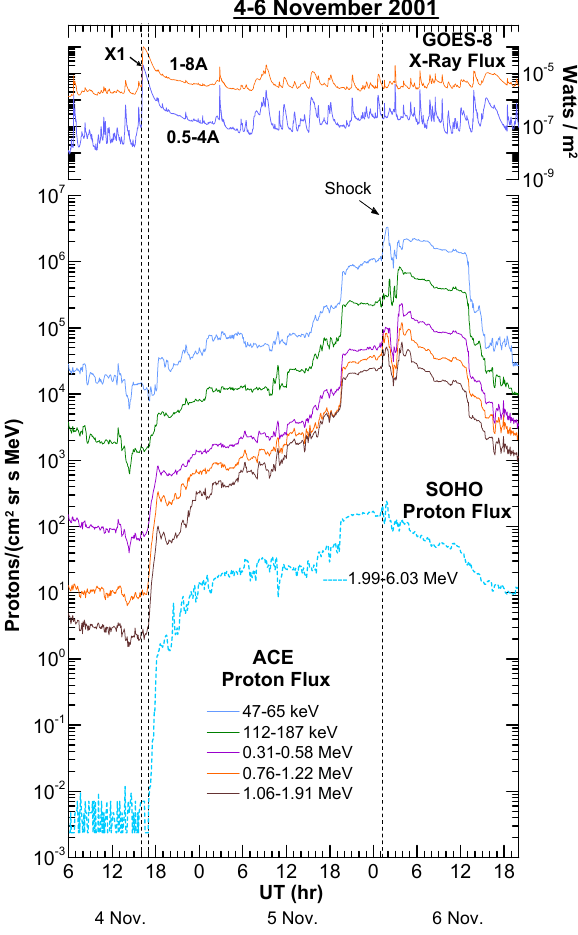
Fig. 3. Upper panel shows X-ray flux at two wavelengths 0.5–4 ˚A and 1–8 ˚A. Proton flux characteristics in various energy levels of 47–65keV, 112–18keV, 0.31–0.58MeV, 0.76–1.22MeV and 1.06– 1.91MeV (ACE) and 1.99-6.03 MeV (SOHO) for 4–6 November 2001 are shown in the lower panel.